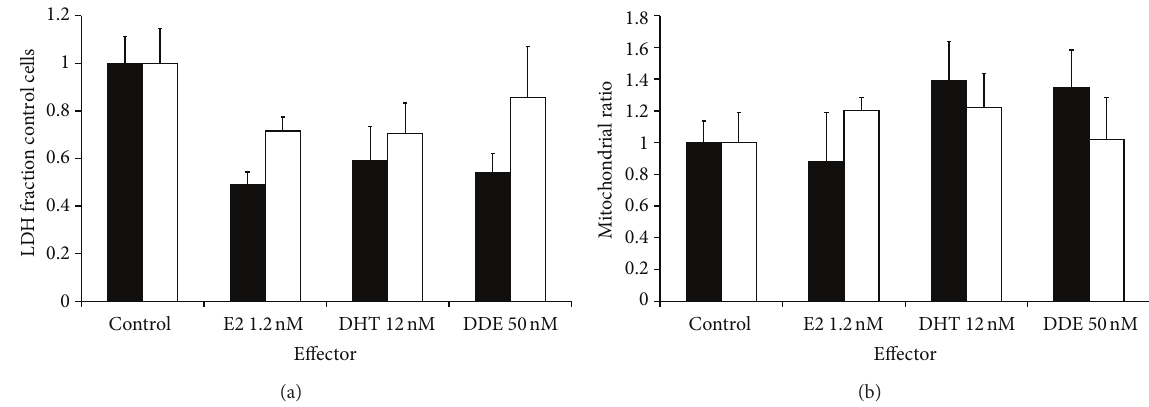
Figure 3: Effects of E2, DHT, and DDE on normal human astrocyte and human cortical neuron growth and XTT/LDH ratio. The figure shows the changes in normal human astrocyte (black bars) and human cortical neuron (white bars) growth (LDH level, left column) and the XTT/LDH ratio (right column) over four days in the presence of 1.2nM E2, 12nM DHT, and 50nM DDE. Each bar represents 15 individual wells of cells and the error bars are the SD. E2, DHT, and DDE inhibit astrocytic and neuronal cell growth and cause changes in mitochondrial levels. DDE: dichlorodiphenyldichloroethylene; DHT: dihydrotestosterone; E2: estradiol; LDH: lactate dehydrogenase; SD: standard deviation; XTT: 2,3-bis(2-methoxy-4-nitro-5-sulfophenyl)-2H-tetrazolium-5-carboxanilide; XTT/LDH: ratio of XTT/LDH indicative of mitochondrial function per